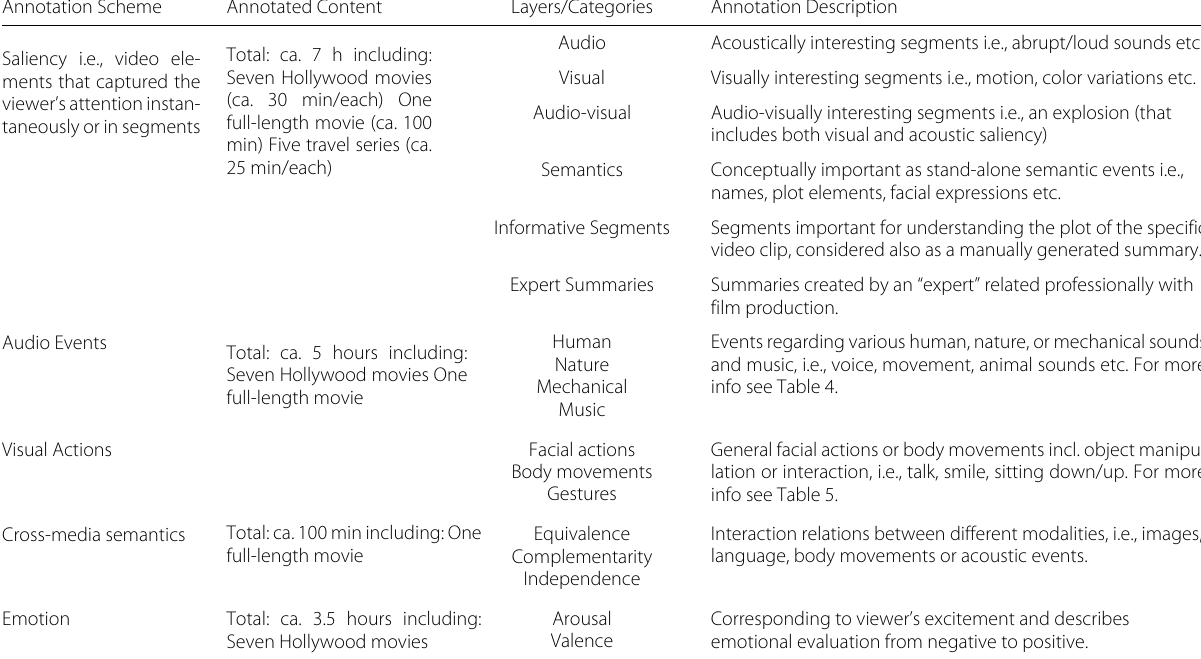
Table 1 Annotation schemes included in the COGNIMUSE database, providing also a brief description for each